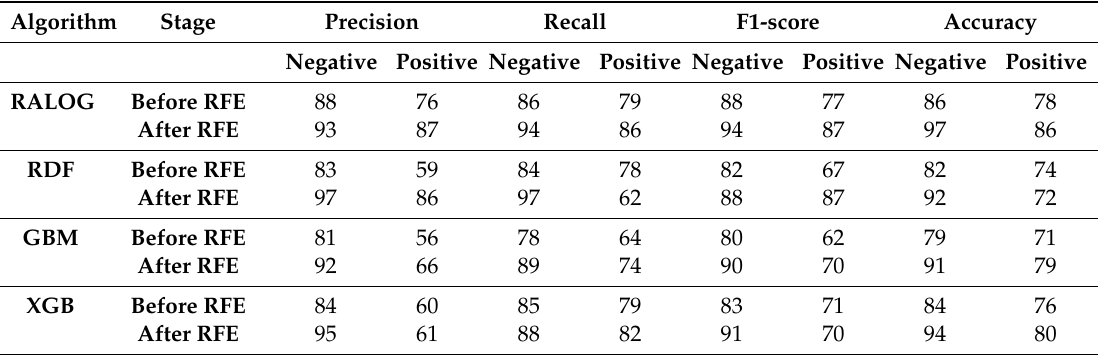
Table 7. Percentage precision, recall and F1-score and accuracy at each experimental stage of feature scaling with the RF-RFE algorithm.